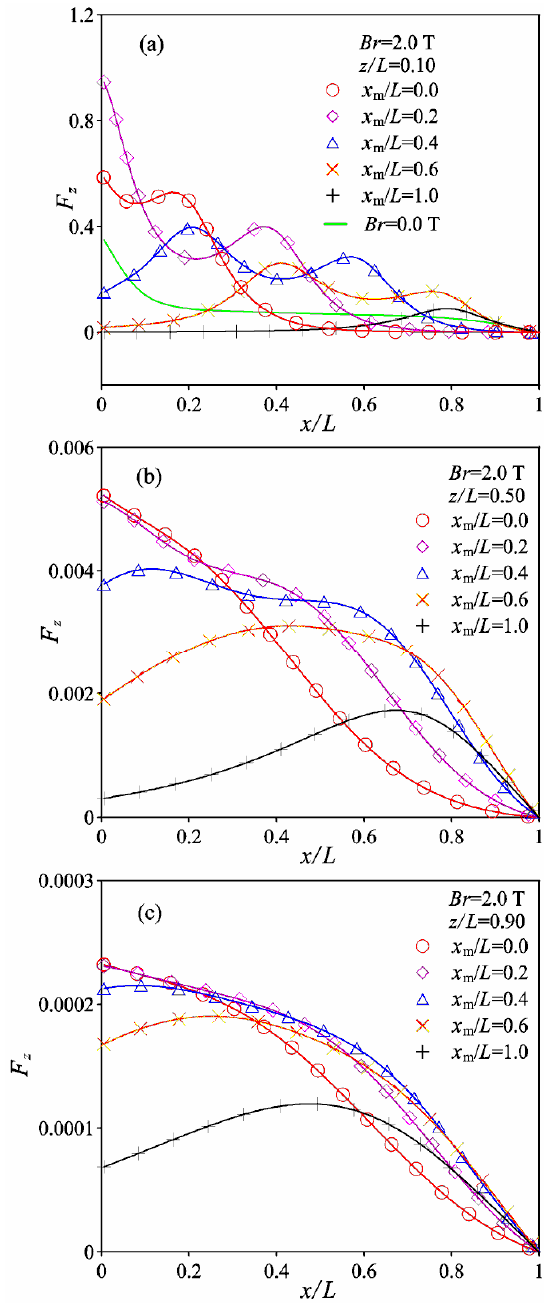
Figure 8. Effects of location of magnet on magnetic buoyancy force F z , ( a ) z / L = 0.10, ( b ) z / L = 0.50, and ( c ) z / L = 0.90.